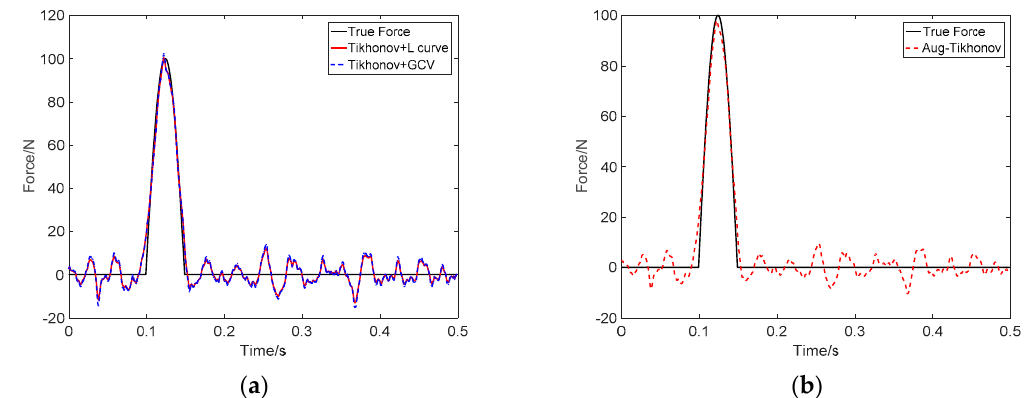
Figure 11. Identification result of impact load at SNR 40 dB: ( a ) Tikhonov method; ( b ) the proposed method.